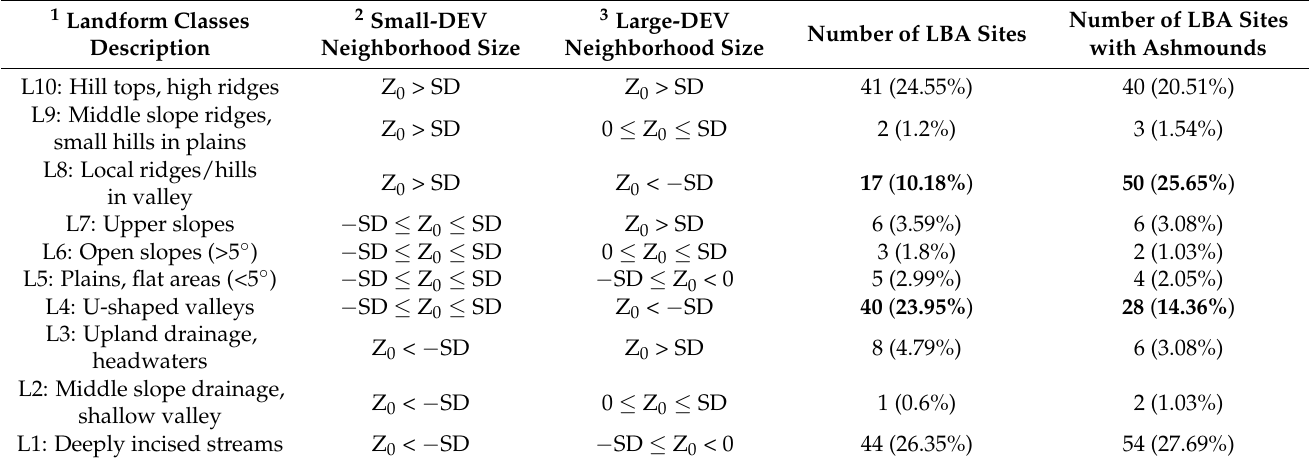
Table 7. Descriptive statistics of LBA sites (see Figure 7c) vs. LBA sites with ashmounds (see Figure 7d) occurring over ten landform classes in the Jijia